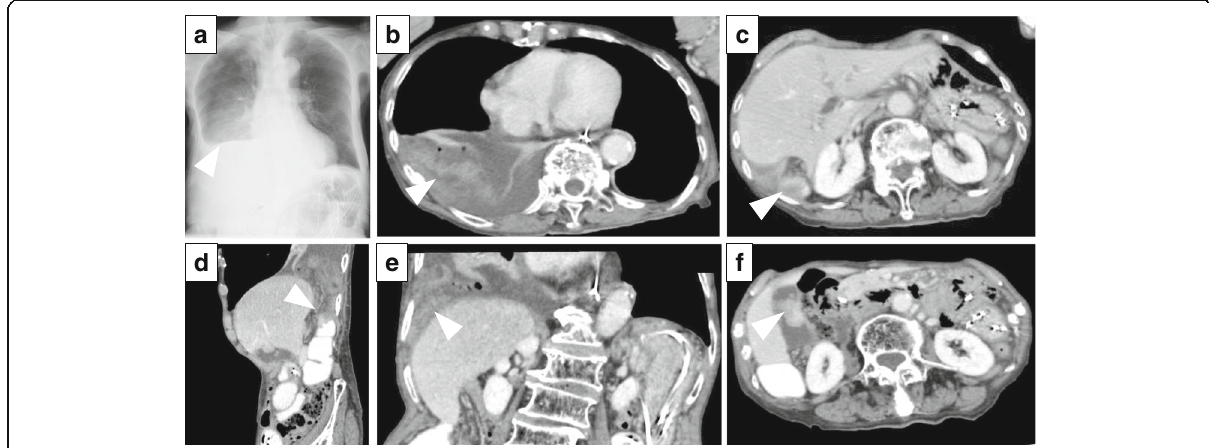
Fig. 1 Radiographic images of the adult right-sided Bochdalek hernia prior to surgery. a Chest X-ray showed intestinal gas over the liver and an elevated right hemi-diaphragm (white arrow head). b A computed tomography (CT) scan of the abdomen and pelvis demonstrated reduced contrast uptake and thickening of the herniated small intestinal wall. The herniated small intestine was present in the thorax (white arrow head). c CT scan of the abdomen and pelvis demonstrated herniation of the small intestine into the right thoracic cavity from the posterior surface overlying the right hepatic lobe (white arrow head). It also demonstrated reduced contrast uptake and thickening of the herniated small intestinal wall. The liver was not atrophic. d A sagittal sequence of CT scans confirmed herniation of the small intestine into the right thoracic cavity from the posterior surface overlying the right hepatic lobe (white arrow head). e A coronal sequence of CT scans also demonstrated herniation of the small intestine into the right thoracic cavity from the posterior surface overlying the right hepatic lobe (white arrow head). f CT scan of the abdomen and pelvis also demonstrated a torose lesion in the gallbladder (white arrow